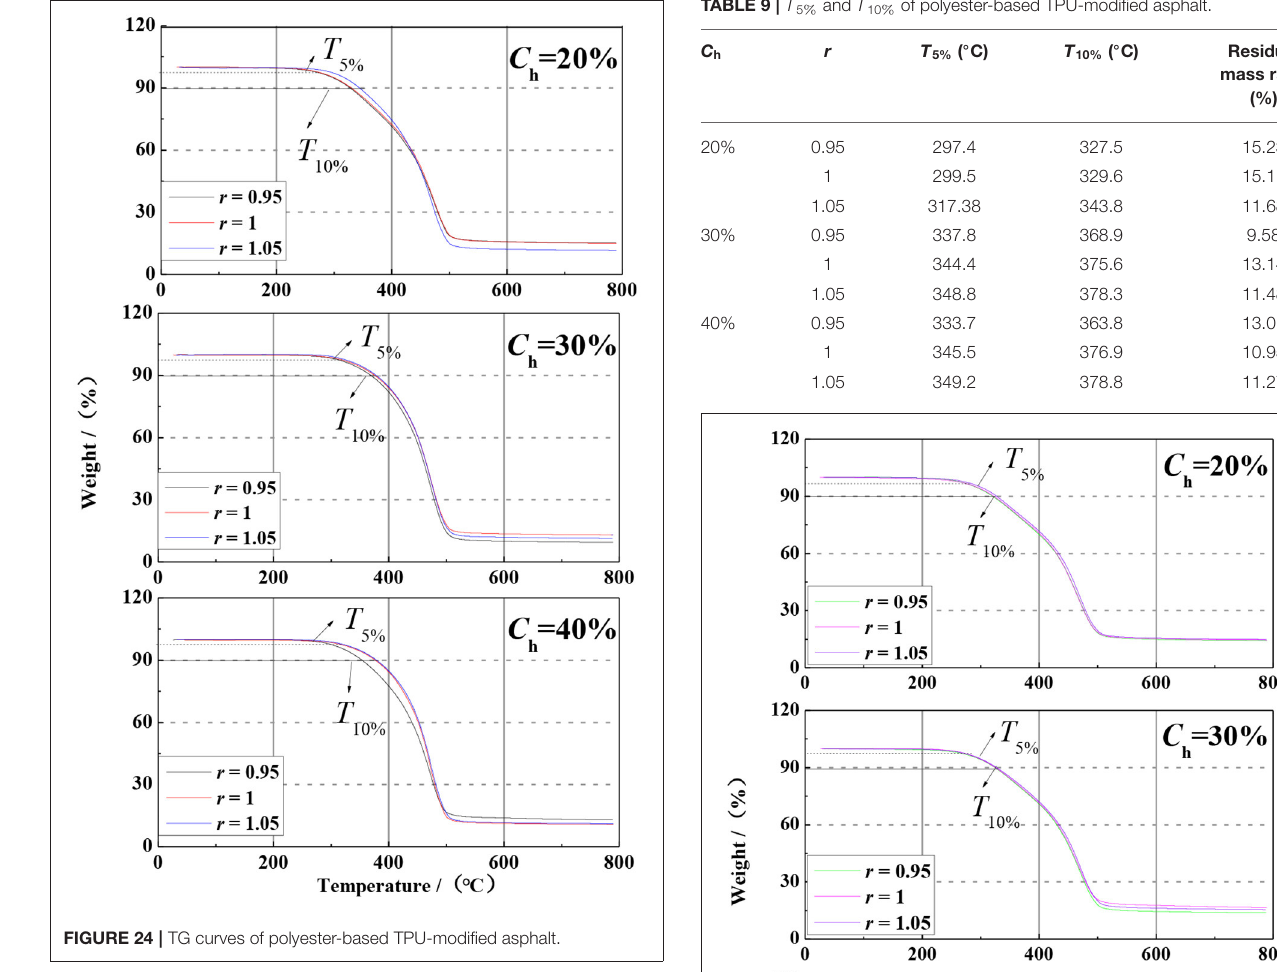
TABLE 9 | T 5 % and T 10 % of polyester-based TPU-modified asphalt.